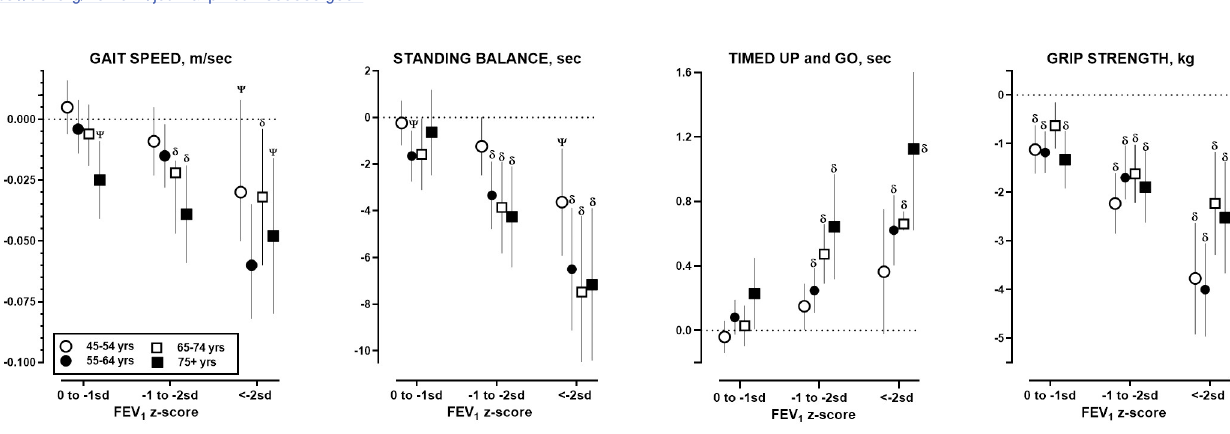
Fig 5. Associations between physical performances with grades of FEV 1 stratified by age. FEV 1 , forced expiratory volume in 1 second; SD, standard deviation.